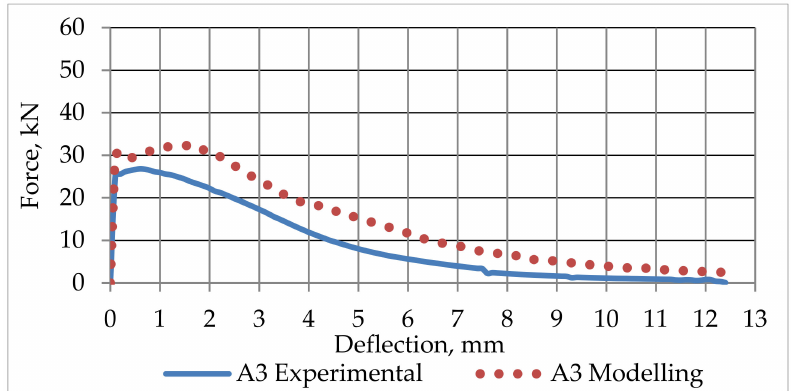
Figure 29. Experimental and modelling graphs for Group